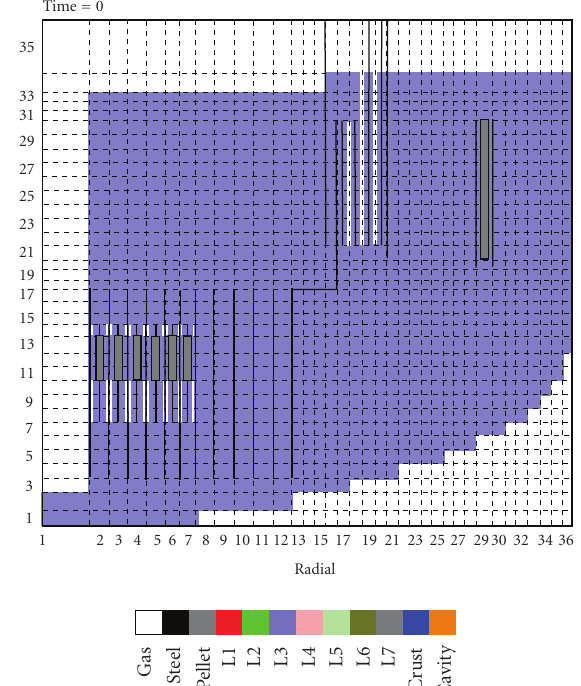
Figure 3: SIMMER-III nodalization scheme of the EFIT